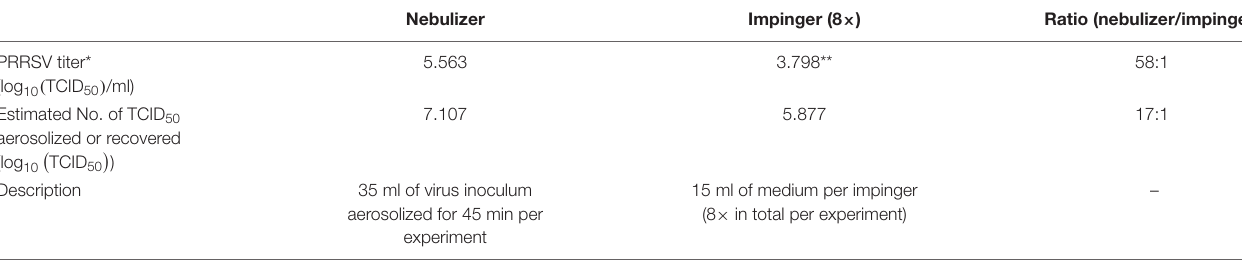
TABLE 5 | Measured and estimated TCID 50 values from the medium in the nebulizer and in impingers.